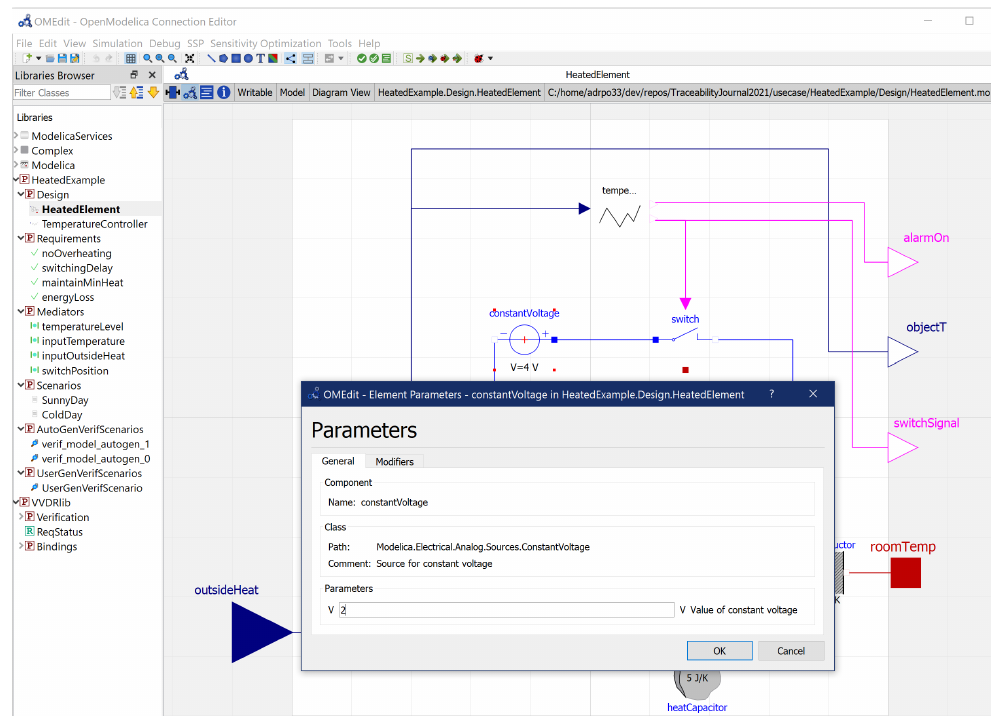
Figure 12. Changing the voltage in the HeatingElement via OMEdit.